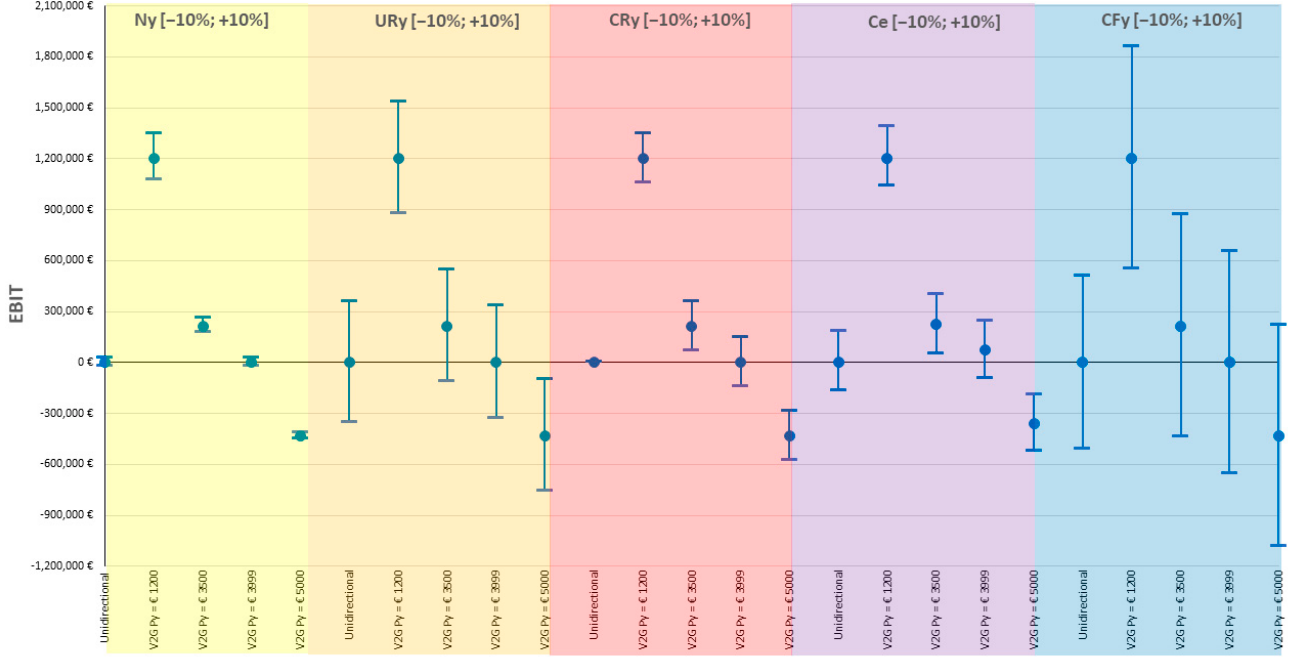
Figure 7. EBIT (EUR) sensitivity to elected revenues and costs.